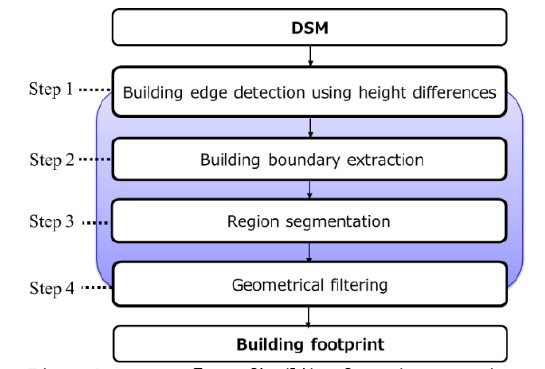
Figure 2. Process flow of building footprint extraction